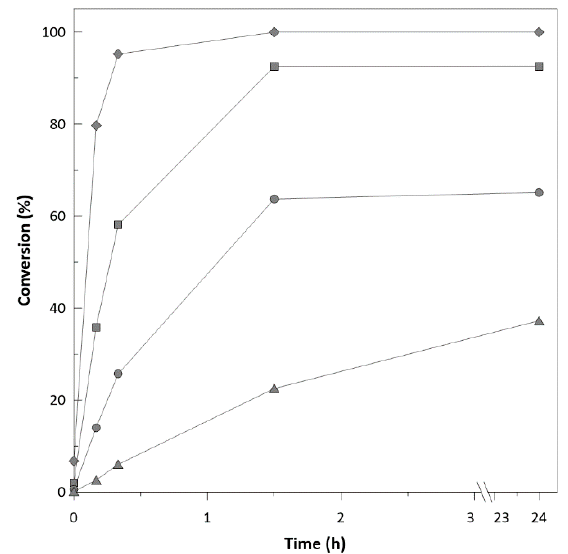
Figure 1. Achieved substrate conversion with different initial substrate concentrations (ethyl-2- methyl-acetoacetate: ♦ 35 mM; ■ 70 mM; ● 100 mM; ▲ 130